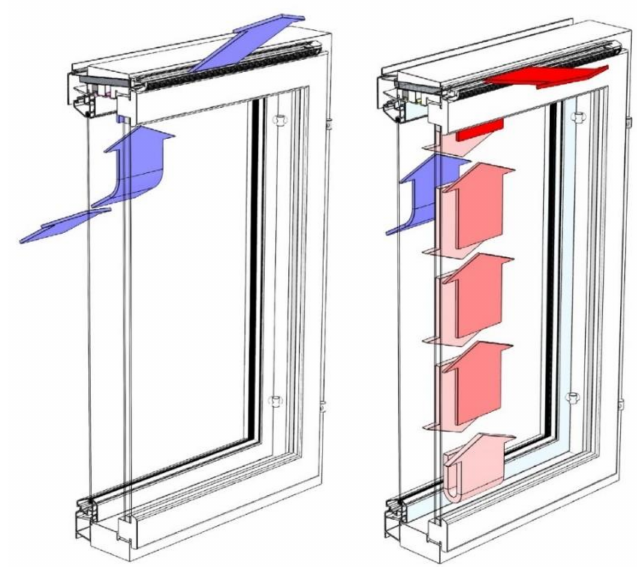
Figure 1. The principle of the supply air window in summer position ( left ) and in winter position ( right ). When the air flows through the window structure, the air flow is heated. To meet the purity requirements of the supply air and to keep the windows cleaner, the outdoor air is usually filtered. To avoid excessive room temperatures, the better performance of windows should be considered when calculating heating